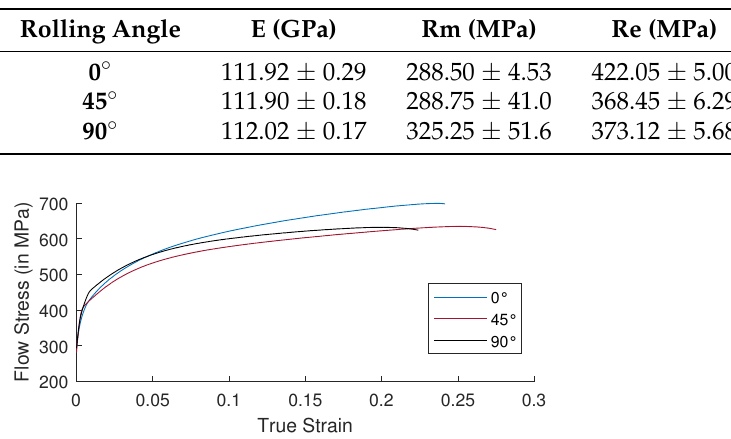
Figure 12. Flow curve of Grade 2 titanium for 3 directions. Figure 13 shows a comparison between experimental data and the Swift model. Voce’s model gave an error of 1.07 × 10 − 1 , whereas Swift’s model gave an error of 8.27 × 10 − 3 . As a result, Swift’s model was employed. The values of Swift model parameters are shown in Table